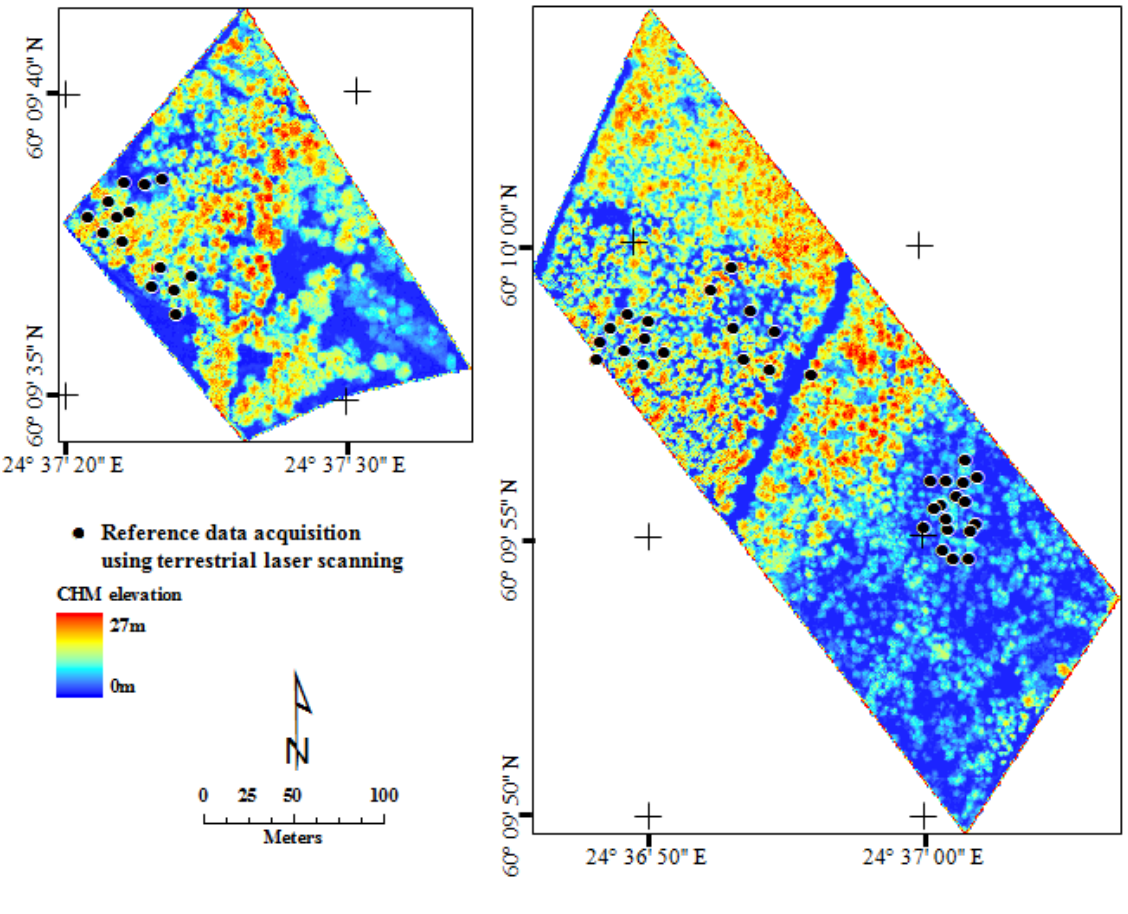
Figure 1. Site A ( Left ) and Site B ( Right ), tree heights shown as color-coded canopy height model